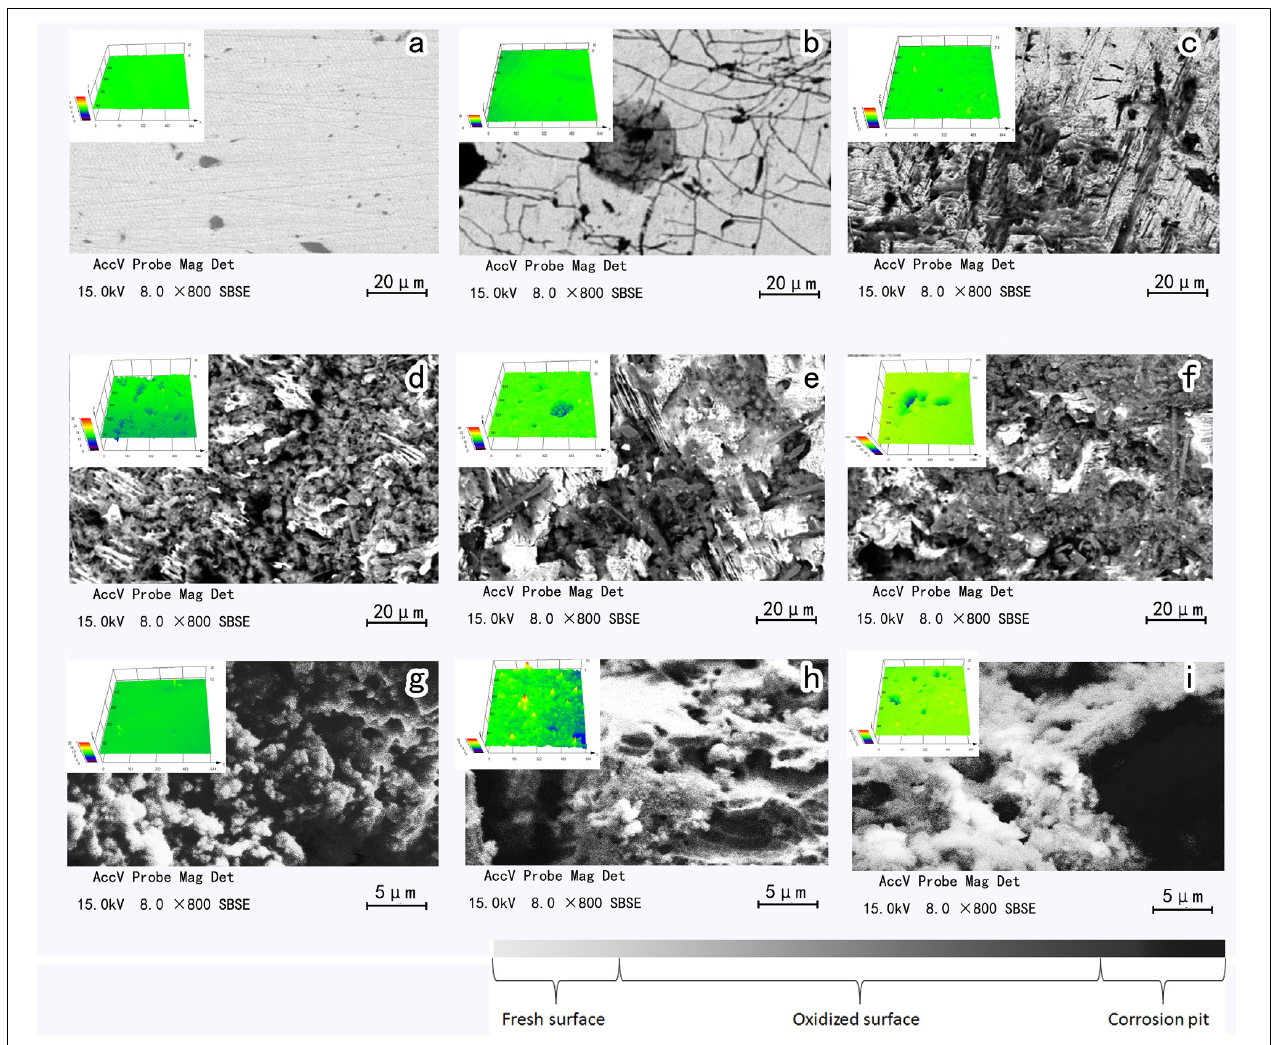
FIGURE 2 | SEM and CLSM images of initial arsenopyrite (a) , arsenopyrite bioleached for 2 days (b) , 4 days (c) , 6 days (d) , 8 days (e) and 10 days (f) and the passive layer on the surface of the samples on sixth (g) , eighth (h) , and tenth (i) day at 45 ◦ C with initial cell density of 1.8 × 10 8 cells/mL, pH of 1.5.